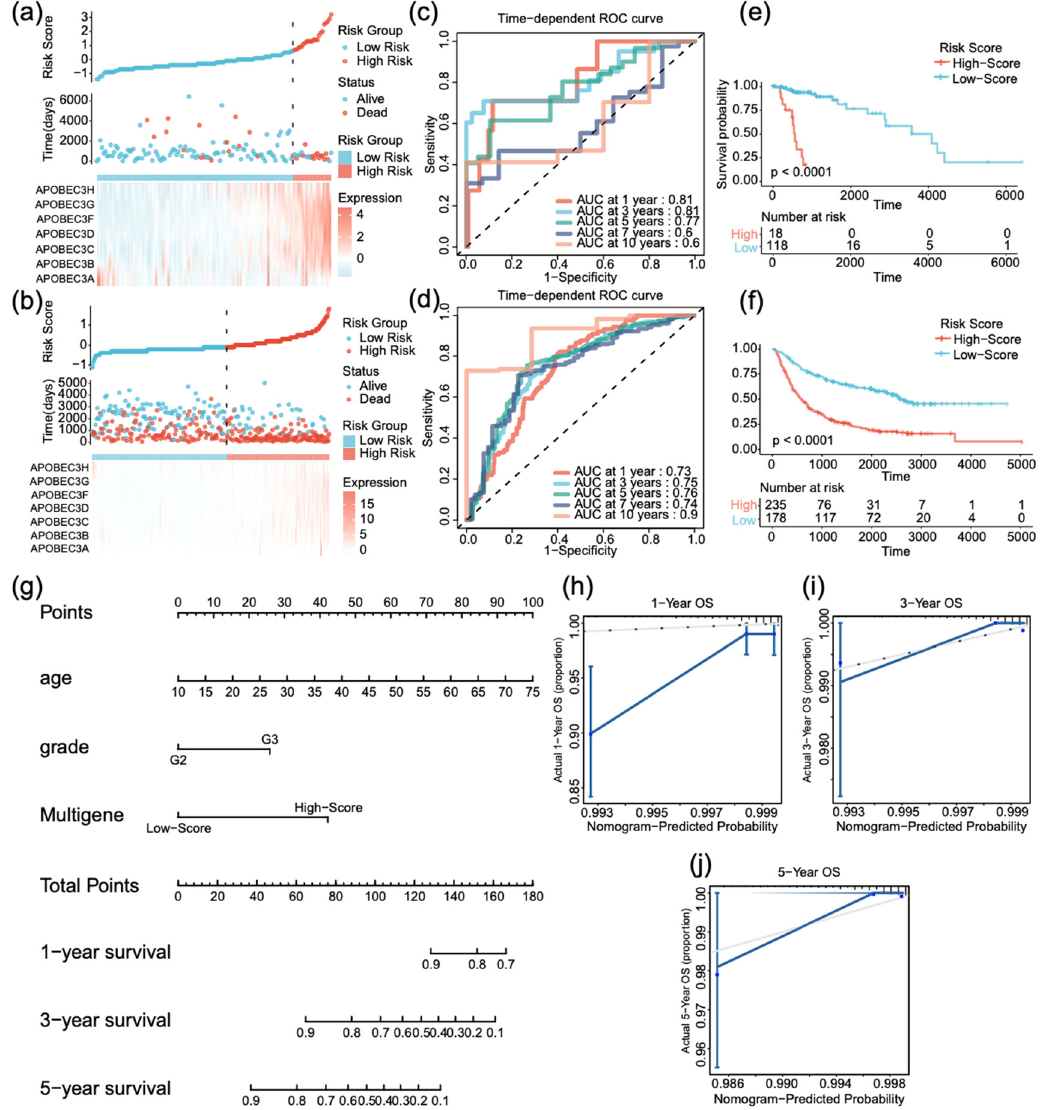
Figure 4. Validation of APOBEC3 signature in TCGA and CGGA cohorts and nomogram construction. ( a , b ) Distribution of risk score, survival time, and gene expression panel in TCGA and CGGA validation cohort. ( c , d ) ROC curve of risk gene signature at 1, 3, 5, 7, and 10 years in TCGA and CGGA cohort. ( e , f ) Kaplan–Meier curves of OS based on risk score in TCGA and CGGA cohort. ( g ) Nomogram predicting 1-, 3-, and 5-year OS for low-grade glioma patients based on APOBEC3 signature and other clinicopathological parameters. ( h – j ) The calibration curves of nomogram in predicted and observed 1-, 3-, and 5-year OS.